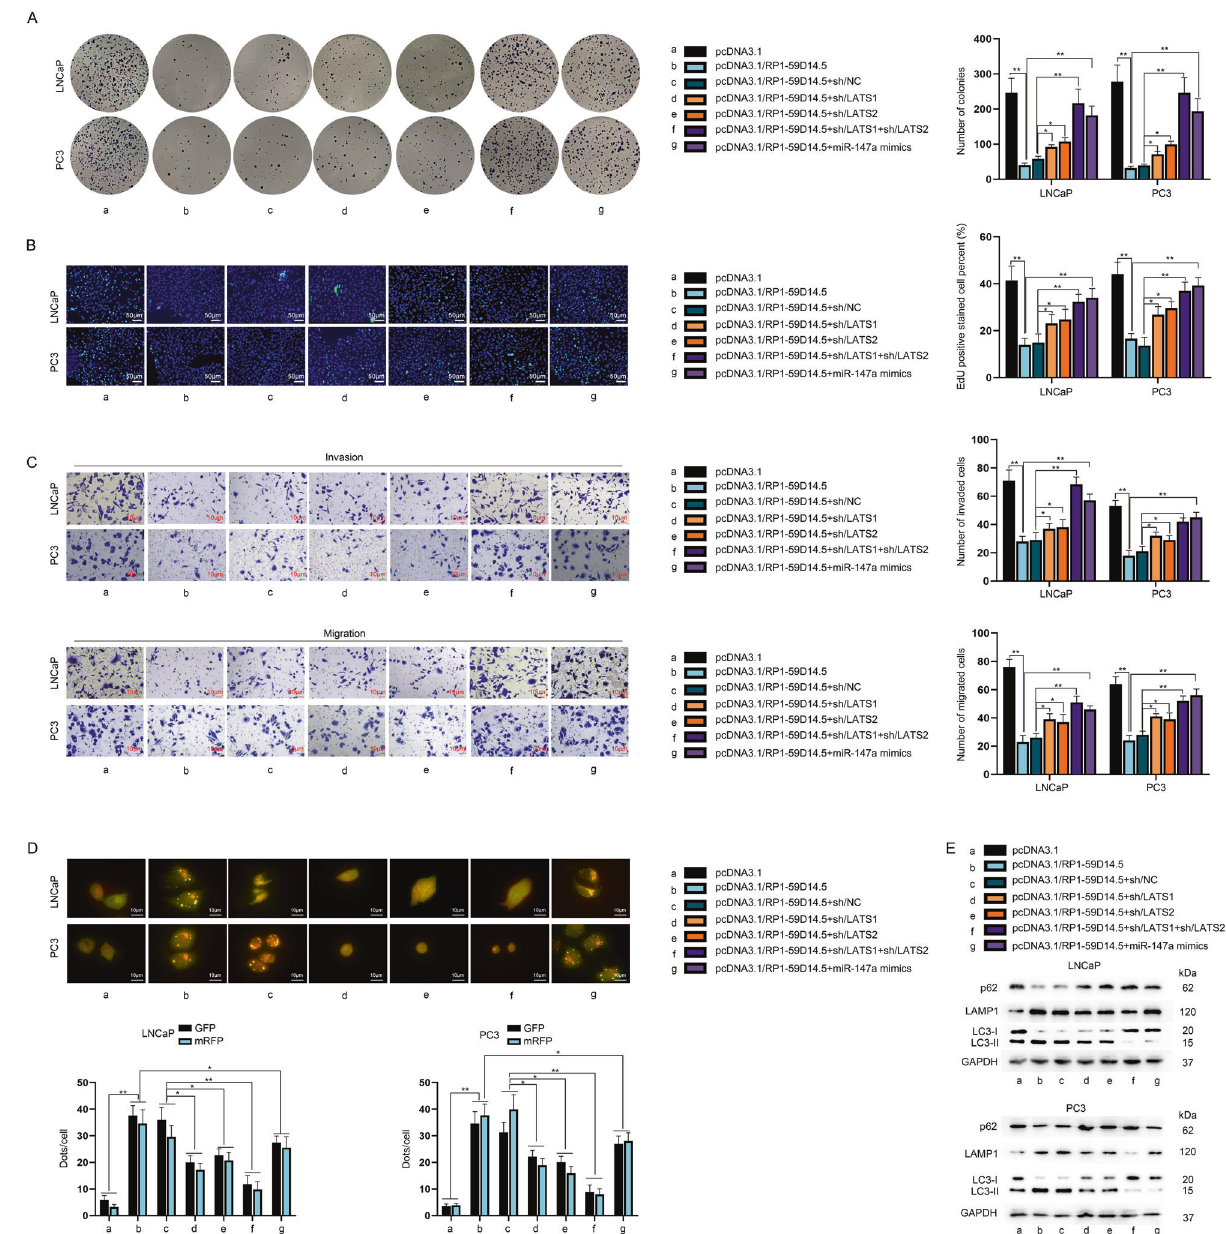
Fig. 4 RP1-59D14.5 affects PCa cell progression via targeting LATS1/LATS2/miR-147a. A , B Colony formation and EdU assays assessed the proliferation of the indicated transfected cells. Scale bar = 50 μ m C Transwell assays detected the invasion and migration of the indicated transfected cells. Scale bar = 10 μ m. D The dots of GFP and mRFP in differently transfected cells were detected by IF analysis and quanti fi ed by RT-qPCR. Scale bar = 10 μ m. E Western blot measured the protein levels of p62, LAMP1, LC3-I/II. * P < 0.05, ** P <